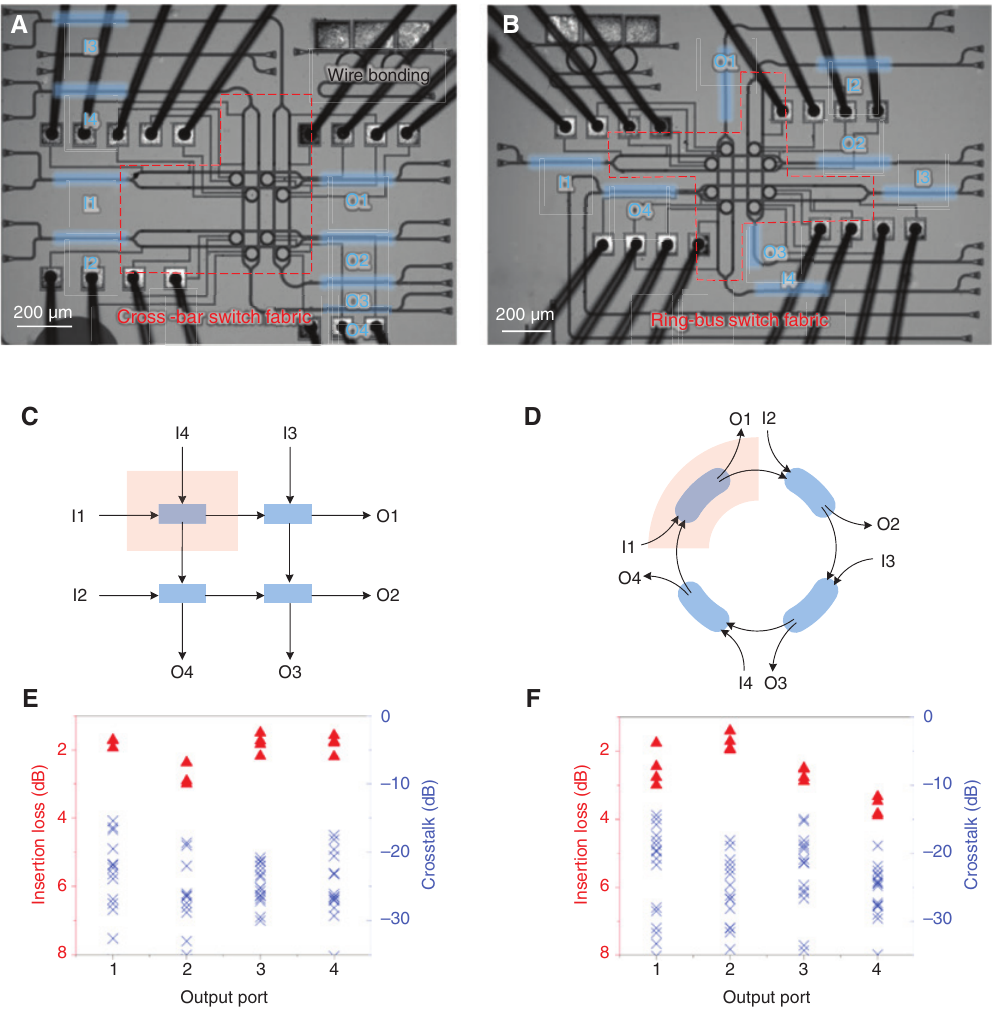
Figure 5: Fabricated multimode switch fabrics. Microscope images of the two types of 4 × 4 switch fabric with (A) cross-bar and (B) ring-bus architecture based on the multimode switch pads. Simplified schematics of (C) cross-bar and (D) ring-bus switch fabrics. The areas highlighted in red refer to the switch element.